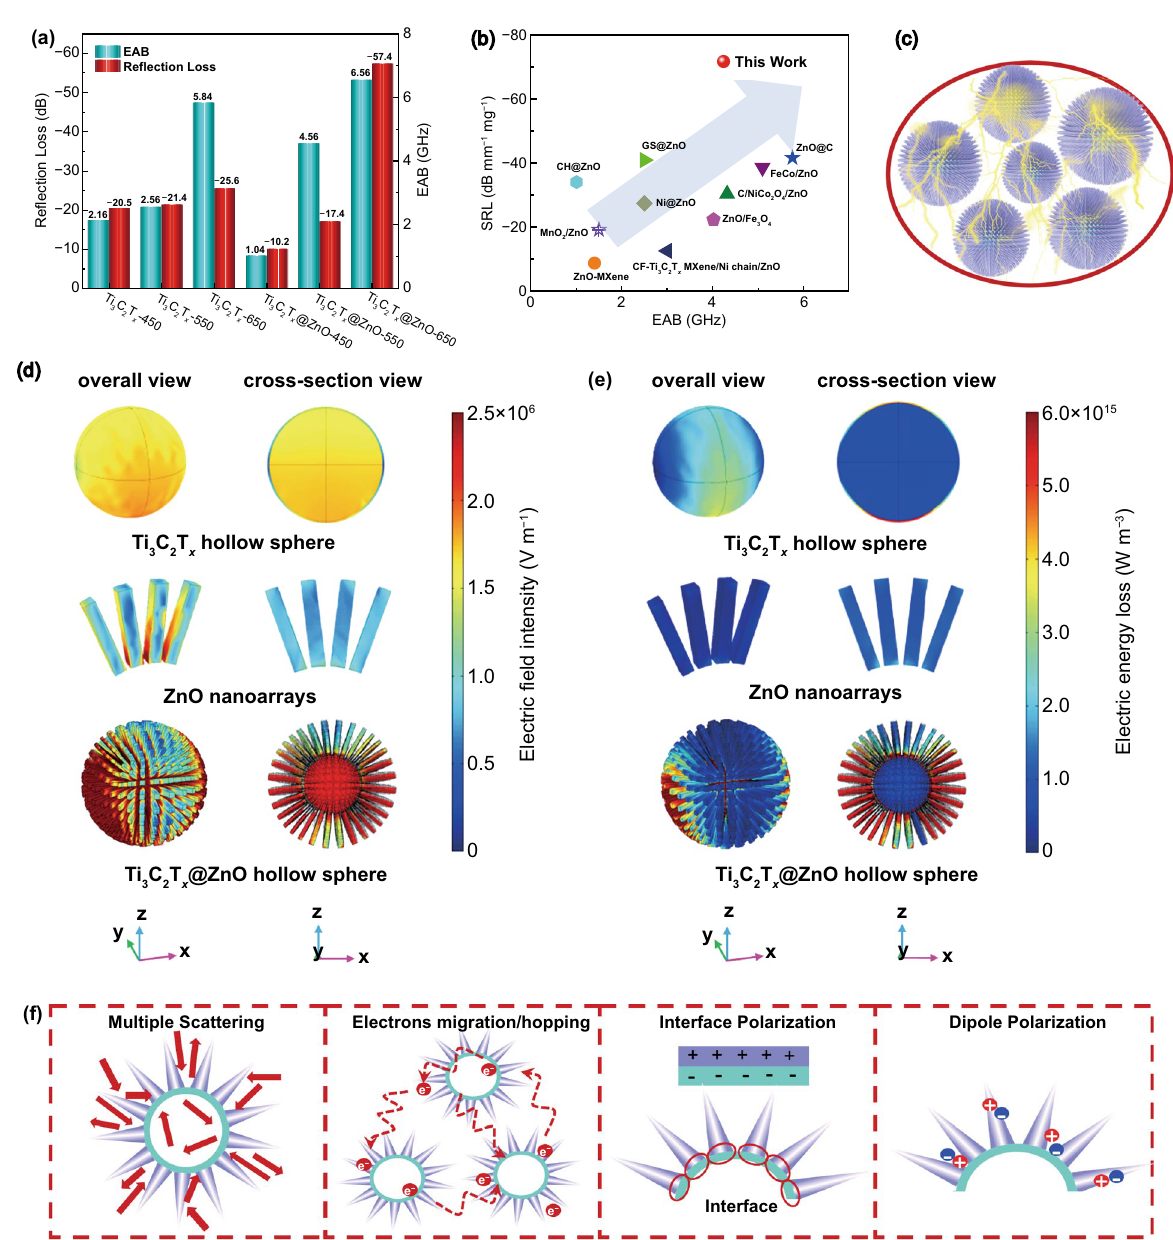
Fig. 4 a Comparison of RL min and EAB of Ti 3 C 2 T x hollow spheres and urchin‑like Ti 3 C 2 T x @ZnO hollow spheres; b SRL and EAB of ZnO‑ based composites; d Complex electric field intensity distribution and e electric energy loss distribution; c , f Schematic illustration of microwave absorption mechanisms for urchin‑like Ti 3 C 2 T x @ZnO hollow